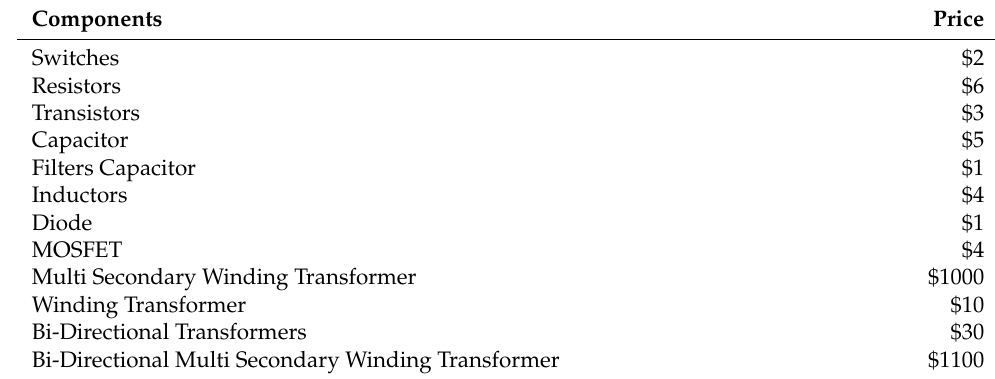
Table 8. Prices of the main components of the equalization methods.